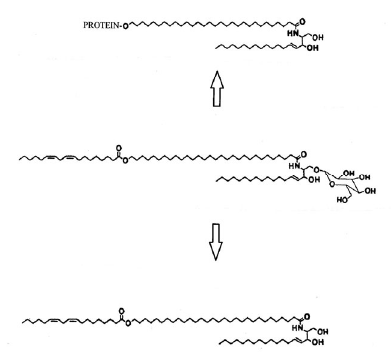
Figure 3. The linoleate-rich acylglucosylceramide (center) is the precursor of the acylceramide (bottom) and the covalently bound ω -hydroxyceramide [5]. This lipid is attached to the outer surface of the cornified envelope and has been referred to as the corneocyte lipid envelope, or CLE. Recently, a 1 ‐ O ‐ acylceramide has been reported as a minor component of stratum corneum lipids [17]. The total of this lipid class is about 5% of the total acylceramide, which is 1% or less of the total stratum corneum lipid. These mainly consist of C18:1 sphingosine with amide ‐ linked fatty acids ranging from 14 ‐ through 34 ‐ carbons in length, and fatty acids ranging from 14 ‐ through 30 ‐ carbons in length ester ‐ linked to the primary hydroxyl group of the long ‐ chain base [18]. Minor species contained C16:1, C17:1, C18:2 and C19:1 sphingosines. The functional role of this lipid family is not presently known.